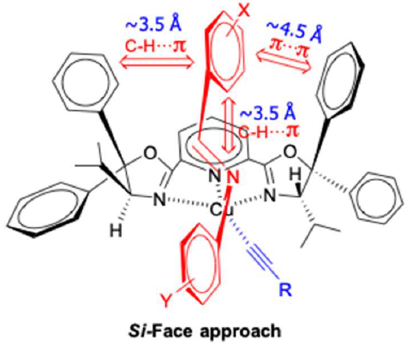
Figure 6. Proposed favored transition state.